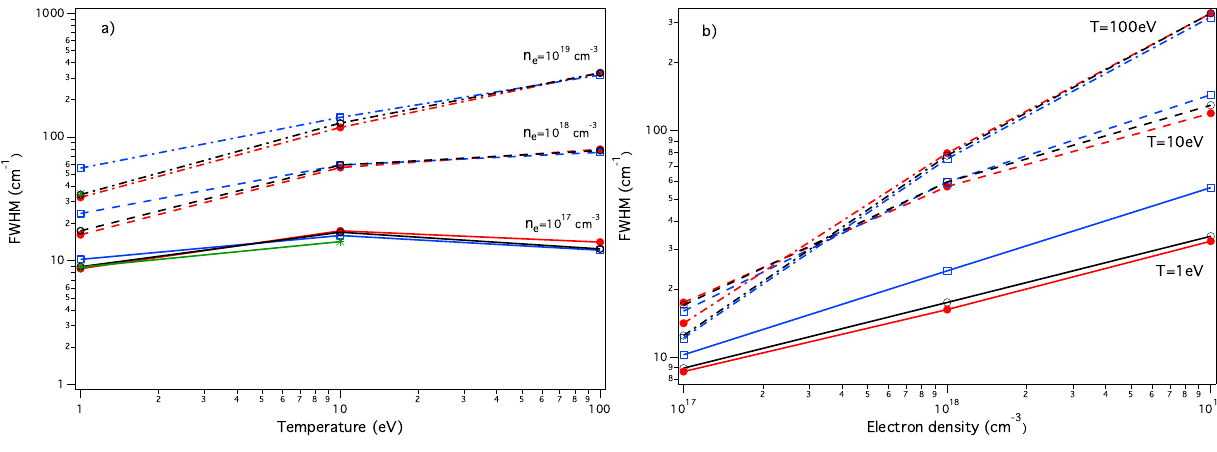
Figure 2. Lyman- (cid:11) ion FWHMs as a function of ( a ) of T at fixed densities and ( b ) of n at fixed temperatures. The ideal, one-component plasma consisting of protons is assumed. Only results from numerical simulations are presented: (red circle) ER-simulation; (blue square) HSTRK; (black dot) SimU; (green asterisk)